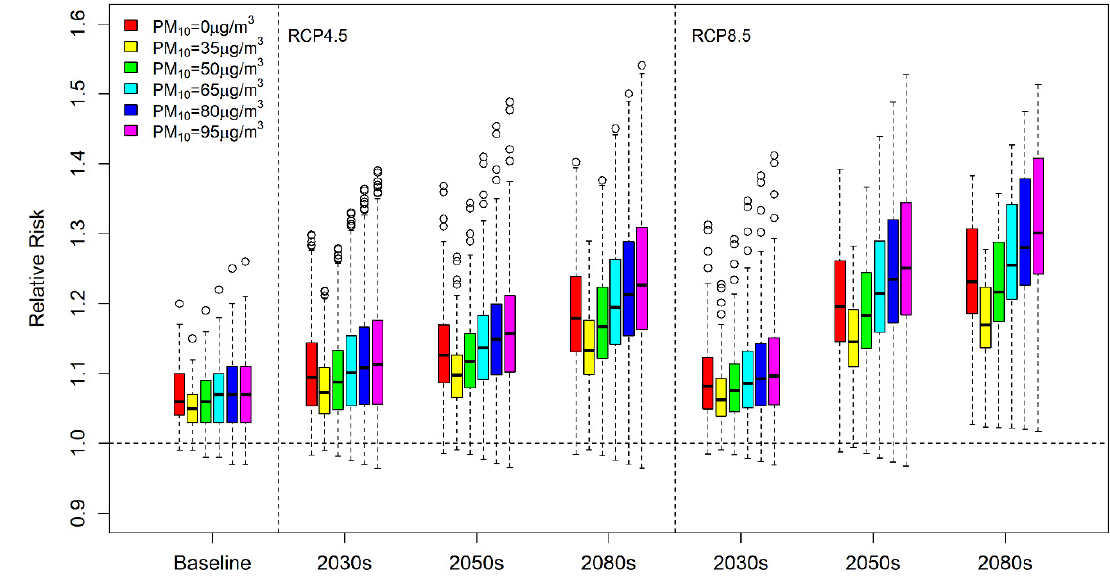
Figure 3. Relative risk boxplots of the 229 districts for the baseline and projection periods (2030s (2026-2035), 2050s (2046–2055), and 2080s (2076–2085)) under predicted temperature scenarios (RCP4.5 and 8.5) and the medium-variant population scenario. Red, yellow, green, light blue, navy, and pink colors correspond to PM 10 levels of 0, 35, 50, 65, 80, and 95 μ g/m 3 , respectively.